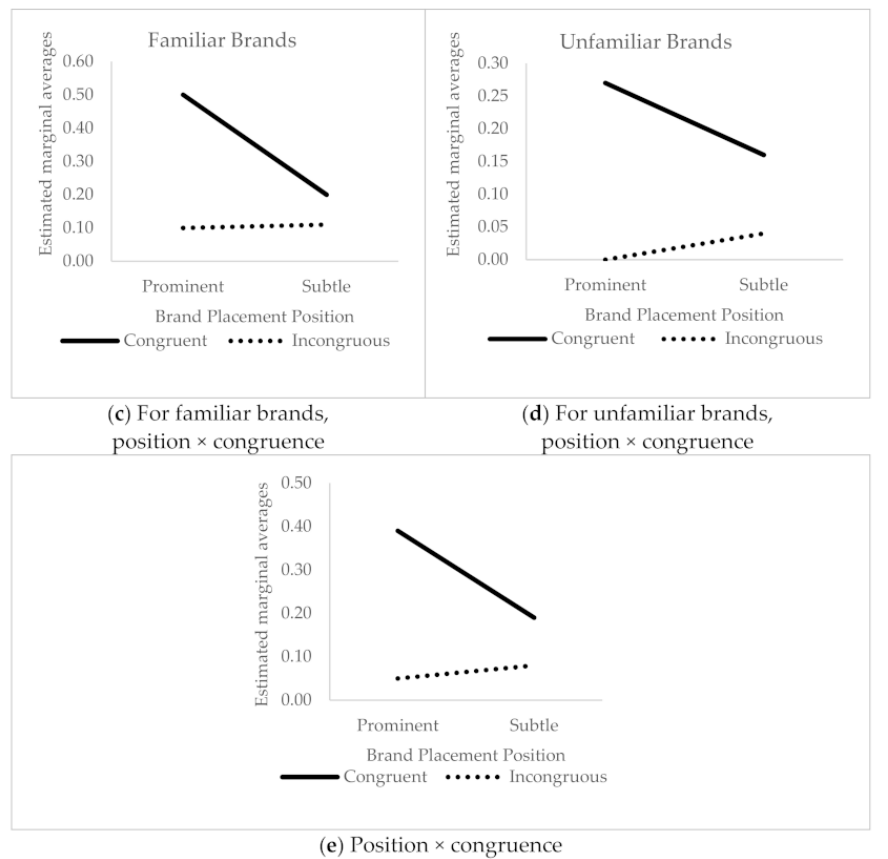
Figure 3. Recognition measurements for each of the experimental conditions: ( a ) position × familiar- ity, ( b ) congruence × familiarity, ( c ) for familiar brands, position × congruence, ( d ) for unfamiliar brands, position × congruence, ( e ) position ×